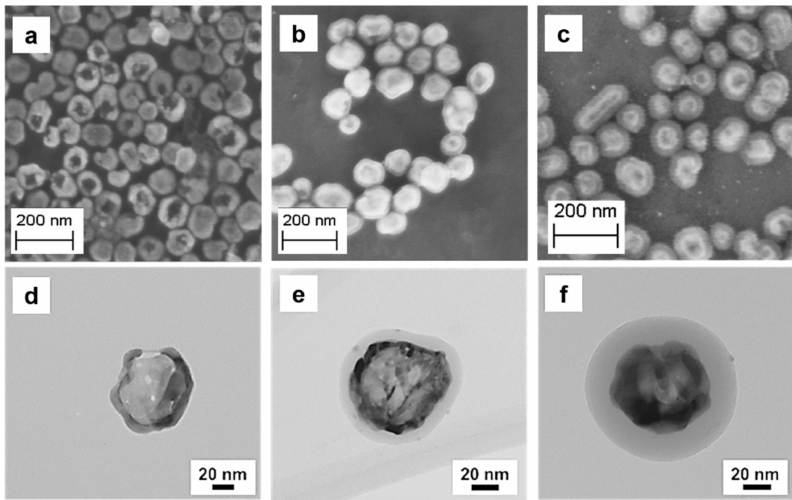
Figure 3. SEM and TEM images of silica-coated hollow gold-silver nanoshells with 900 nm LSPR extinction maxima. The thicknesses of the silica shell are ( a , d ) ~2 nm, ( b , e ) ~10 nm, and ( c , f ) ~15